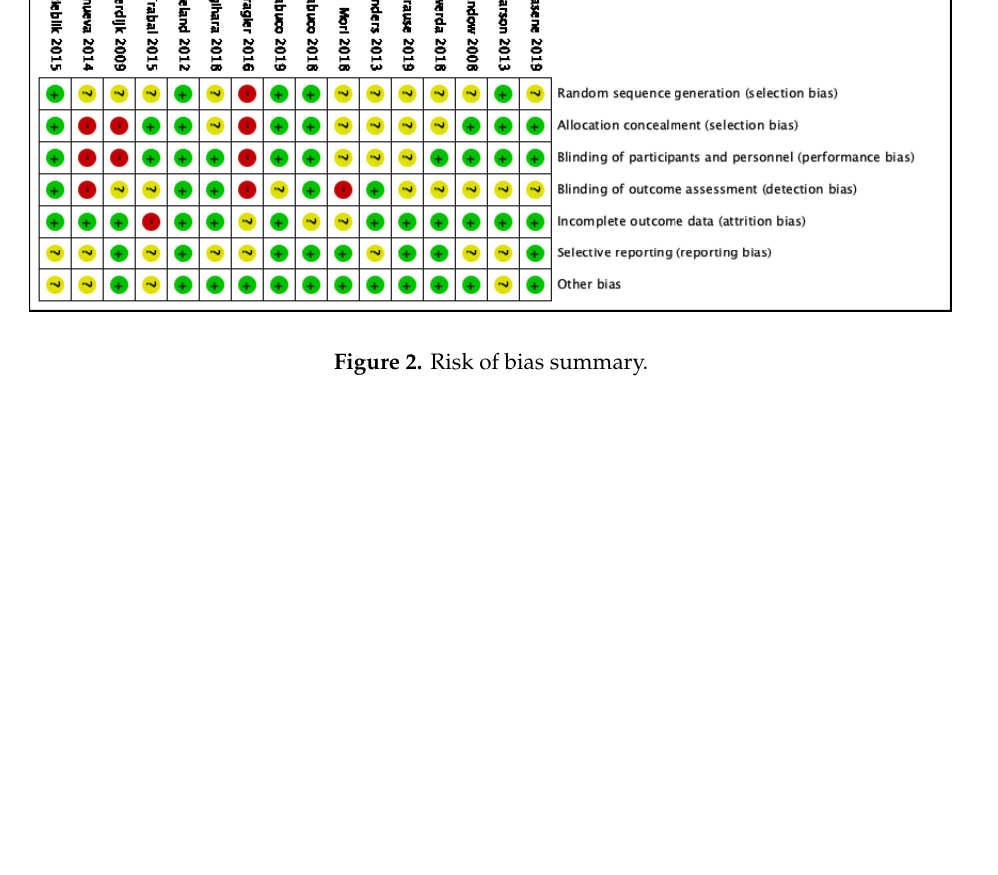
Figure 3. Risk of bias graph.